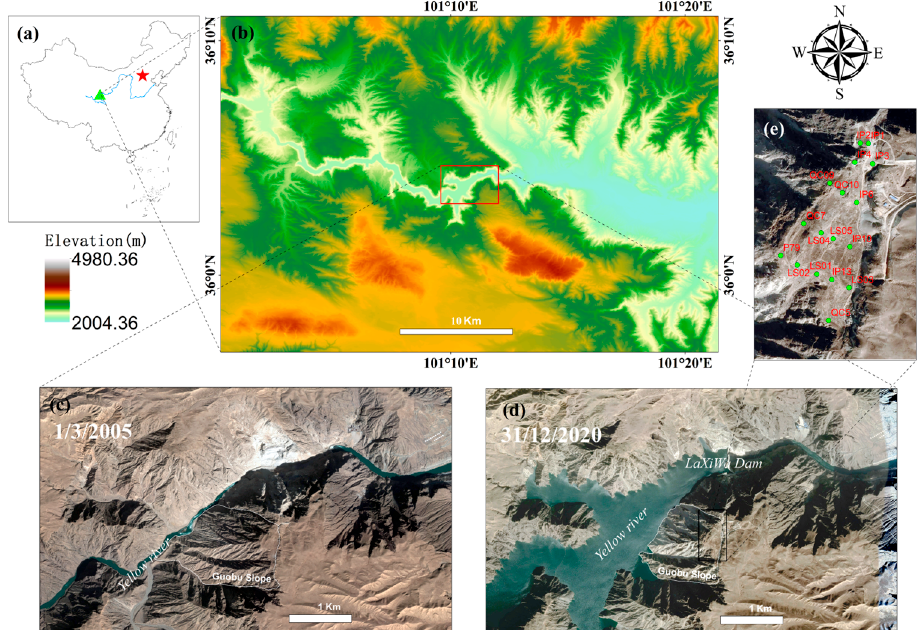
Figure 1. ( a ) Location of Guobu slope in China. The green and yellow blocks indicate the Qinghai– Tibet Plateau and the Loess Plateau, respectively, and the green triangle and the five-pointed star indicate the study area and Beijing; ( b ) DEM of the study area; ( c ) Google Earth image of the study area in 2005; ( d ) Google Earth image of the study area in 2020; ( e ) GPS monitoring point distribution.